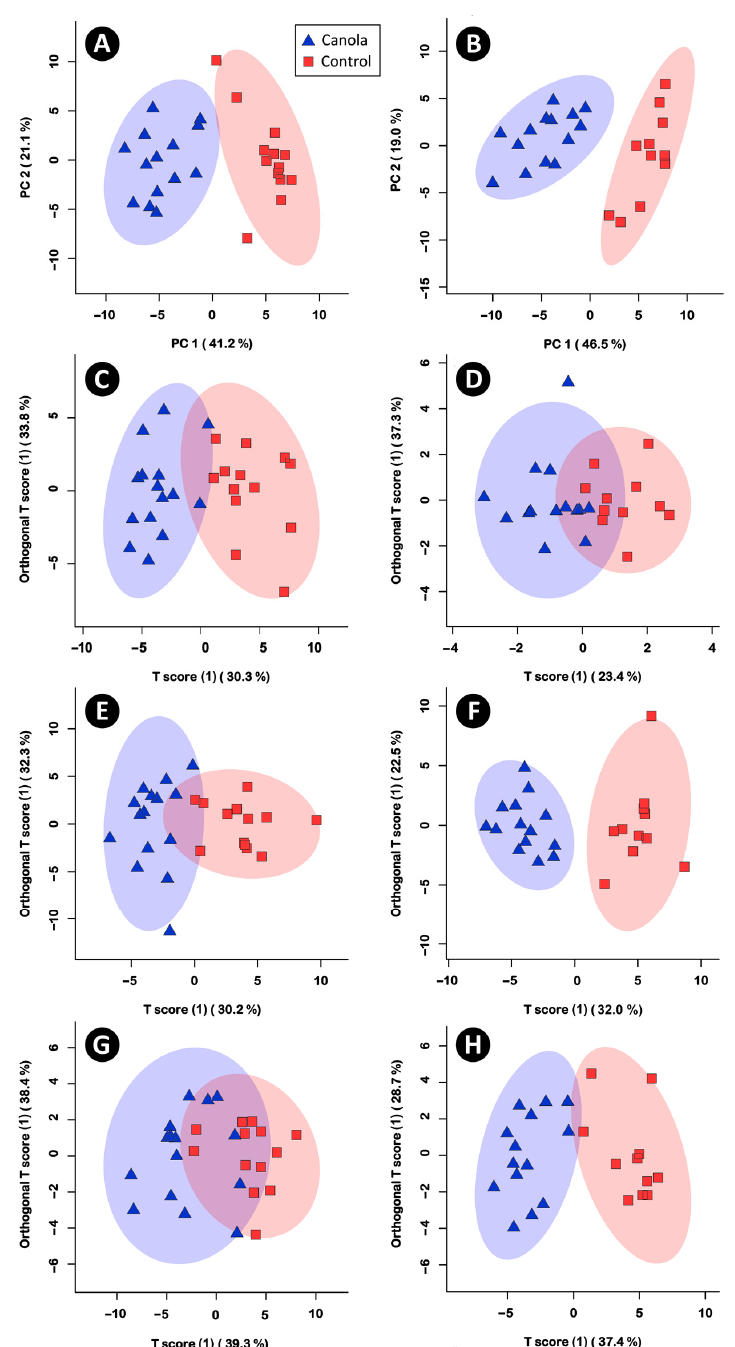
Figure 6. ( A , B ) Principle Component Analysis (PCA) showing unsupervised multivariate analysis of the cecal digesta metabolome among female (left) and male (right) from birds fed a diet supple- mented with canola meal (20%) or a control diet. ( C – H ). Orthogonal Projections to Latent Structures Discriminant Analysis (OPLS-DA) showing supervised separation ( p ≤ 0.014) for female (left) and male (right) birds fed the two diets. ( C , D ) Pancreas. ( E , F ) Liver. ( G , H ) Breast muscle. Each triangle or square represents one individual bird, and ellipsoids represent significant clustering by diet treatment at 95% confidence interval. For Figures A , B , the x-axis represents principle compo- nent 1, and the y-axis represents principle component 2. For Figures C – H , the x-axis represents the between-group variance (T-score), and the y-axis represents within-group variance (orthogonal T- score). Percent values in parenthesis show variances.